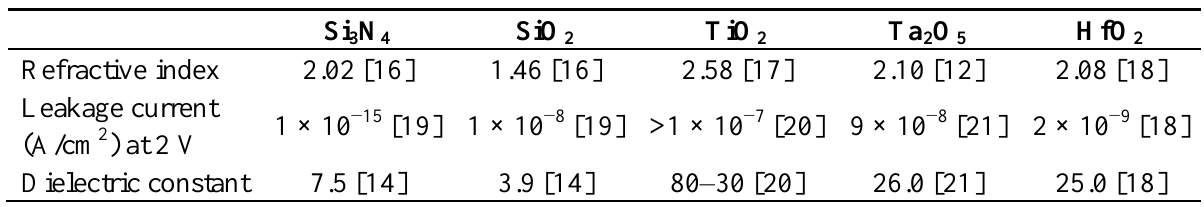
Table 1. Properties of thin layers of various amorphous